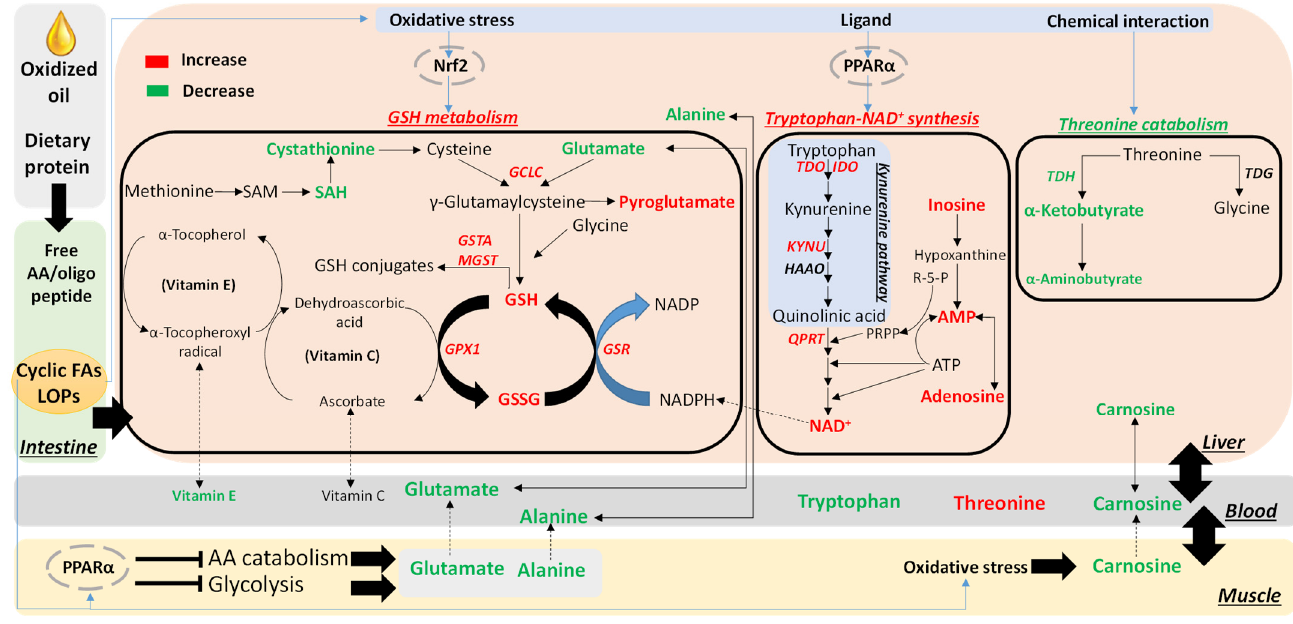
Figure 7. Summary of oxidized corn oil (OCO)-elicited metabolic changes in amino acid metabolism. The activation of tryptophan-NAD + biosynthesis, the expansion of glutathione metabolism, and the inhibition of threonine catabolism, in the liver, as well as the decreases in glucogenic amino acids (alanine and glutamate) in serum and liver, were identified as the most prominent changes in amino acid metabolism after dietary OCO consumption. These selective changes were likely mediated by PPAR α activation, oxidative stress, and Nrf2-mediated antioxidant responses in the liver and muscle. Many of these metabolic events may possess protective functions and might contribute to the tolerance of nursery pigs to the exposure of oxidized lipids.